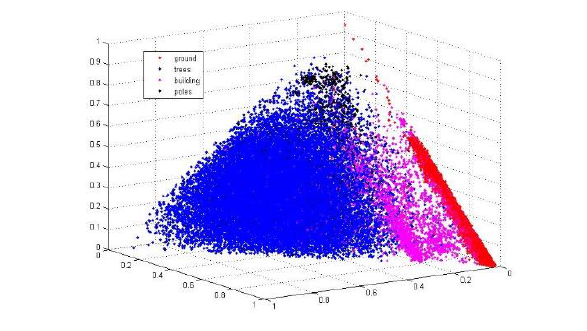
Figure 2. The spectral vectors of objects For p data points, a set of seed points are distributed in space on a grid with resolution R seed . The seed point is the voxel leaf. Then use a region growing method to expand the seed points. measure calculated in a feature space consisting of spatial extent, spectral information, and normal vector. The distance is defined as Equation